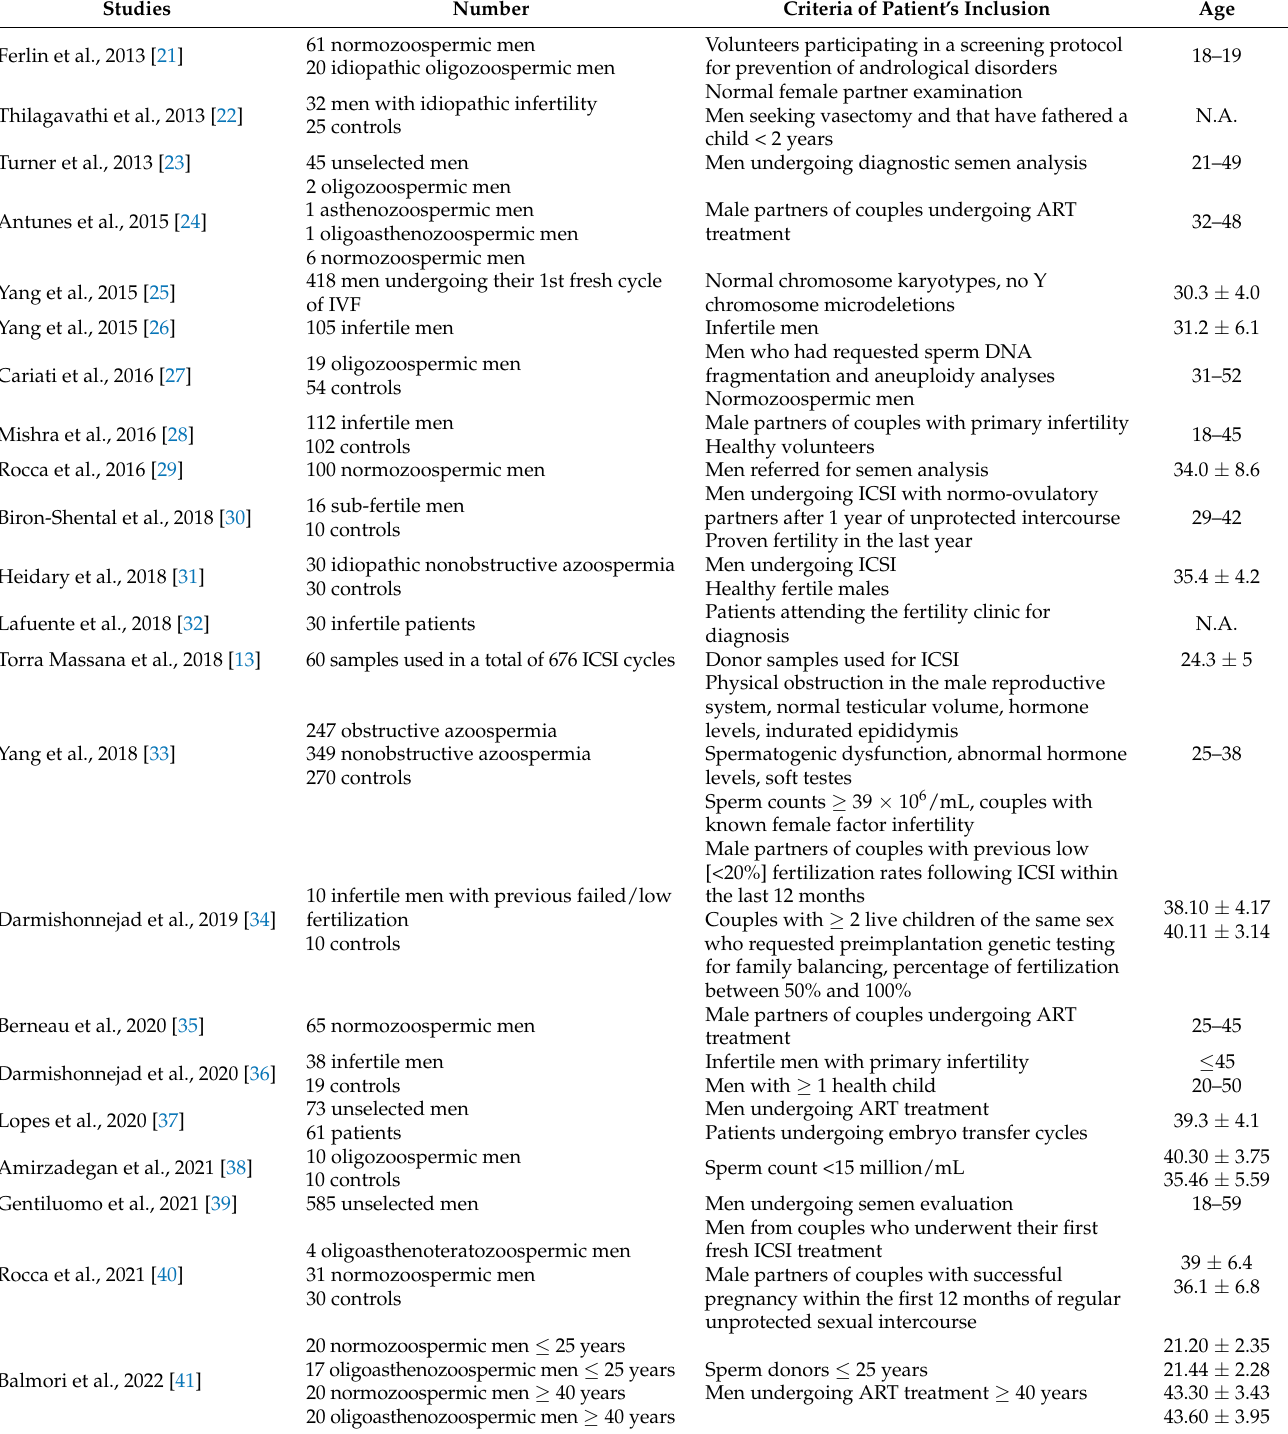
Table 1. Characteristics of patients and controls in the different